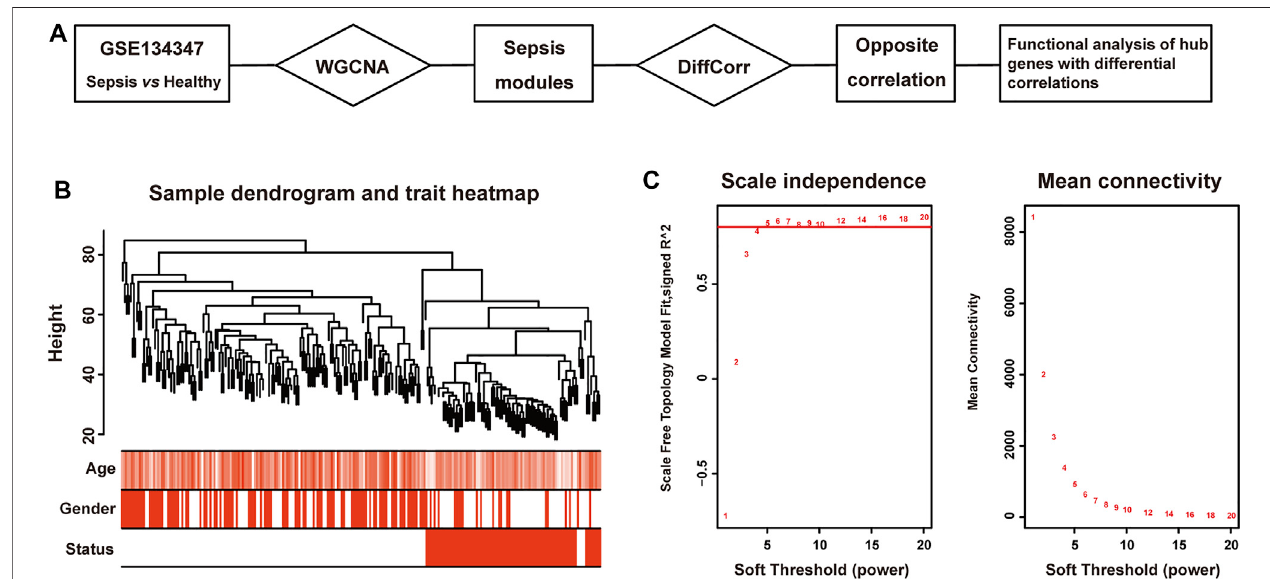
FIGURE 1 | Clustering dendrogram of sepsis and healthy tissues. (A) The work fl ow of this study. (B) Clustering dendrogram of 156 patients with sepsis and 82 healthy subjects and trait heatmap. (C) The relationship between soft threshold (power) and network properties. Left panel: The relationship between soft-threshold (power) and scale-free topology. Right panel: The relationship between soft threshold (power) and mean